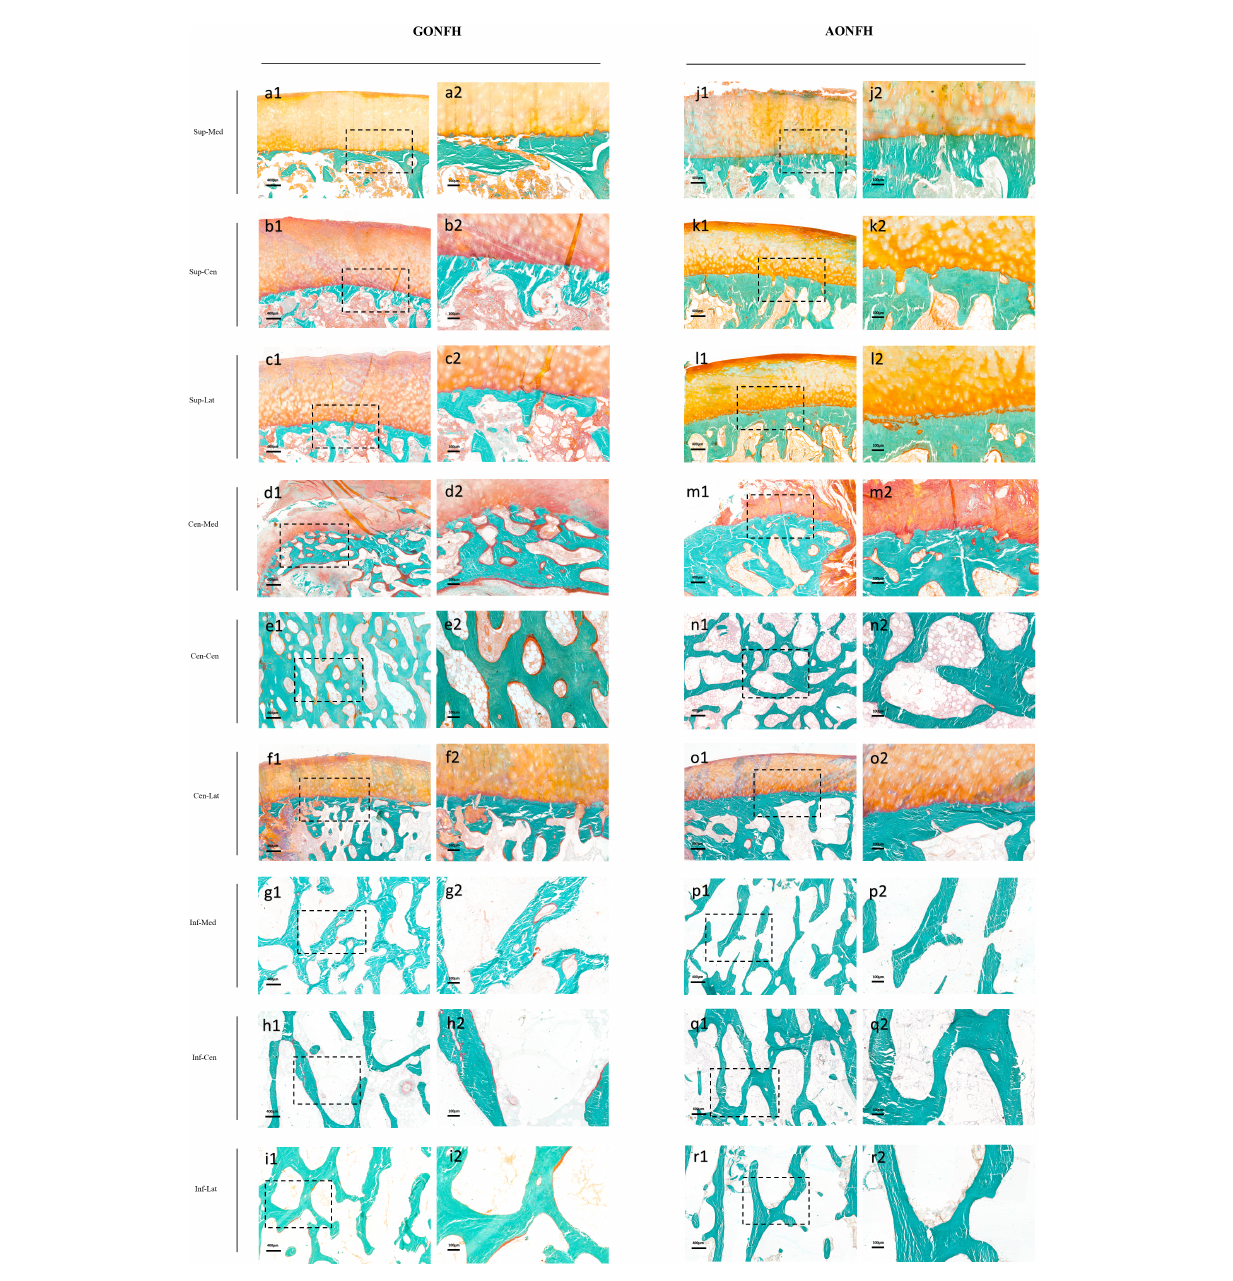
FIGURE 6 Photomicrographs of undecalci fi ed sections of different ROIs in the femoral head from patients with GONFH (A-I) and patients with AONFH (J-R) . Cracks in bone matrix are artifacts which are produced during sectioning of the undecalci fi ed bone specimen. Stain: Goldner's Trichrome; (a1-r1) magni fi cation: ×40; (a2-r2) magni fi cation: